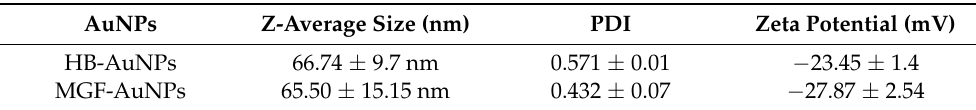
Table 2. Dynamic light scattering (DLS) analysis of HB-AuNPs and MGF-AuNPs. AuNPs Z-Average Size (nm)